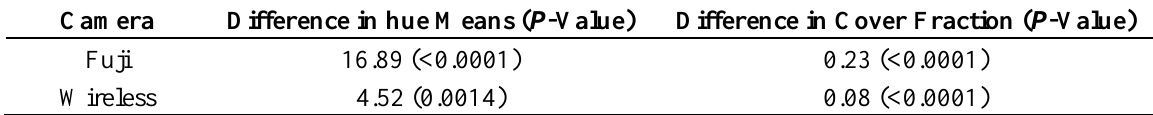
Table 3. Paired t-test for 2013 hue for infected vs . healthy wheat and cover fraction (N =